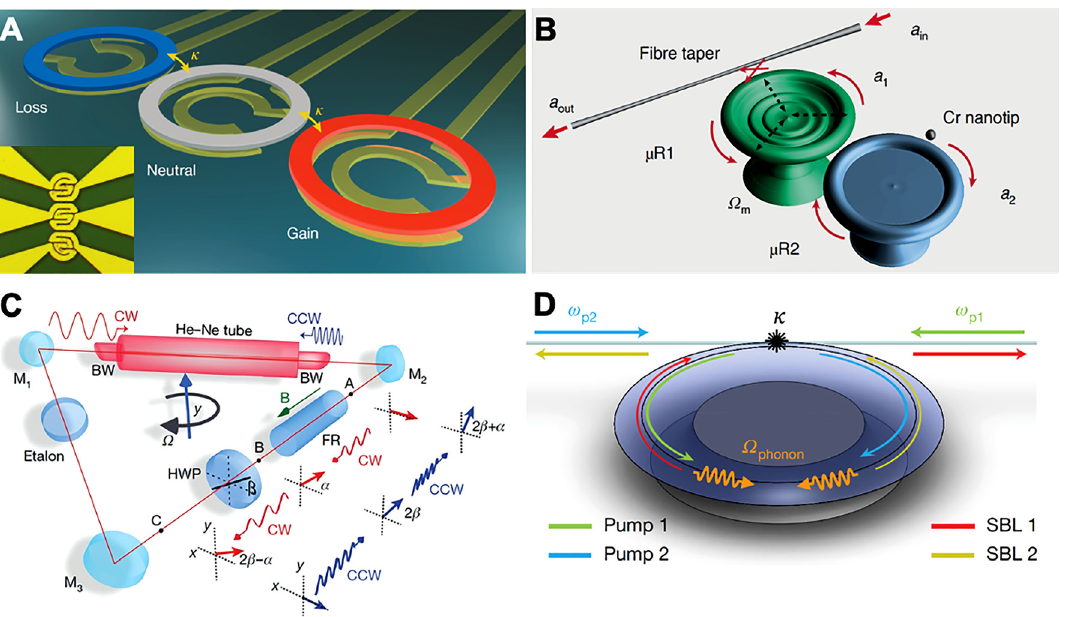
Figure 3: Enhanced sensitivity using exceptional points (EPs). (A) Coupled microring lasers equipped with microheaters used to realize a third-order EP [118]. (B) A coupled microtoroid phonon laser operatingatanexceptionalpoint[53].(C,D)EnhancedSagnaceffectinEP-basedgyroscopesimplementedinaringlasergyroscope[121]anda Brillouin laser cavity [122],